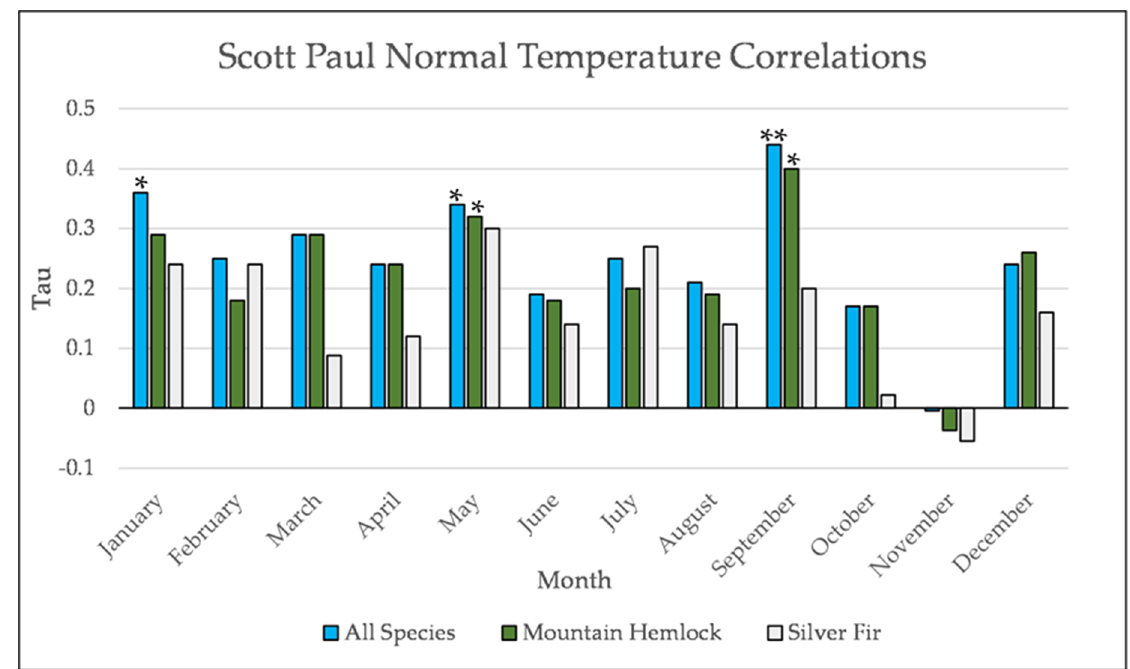
Forests 2021 , 12 , x FOR PEER REVIEW Figure A20. Normal Kendall’s correlation between mean monthly temperature and establishment at the Scott Paul site. * = p -value < 0.05, ** = p -value < 0.01.